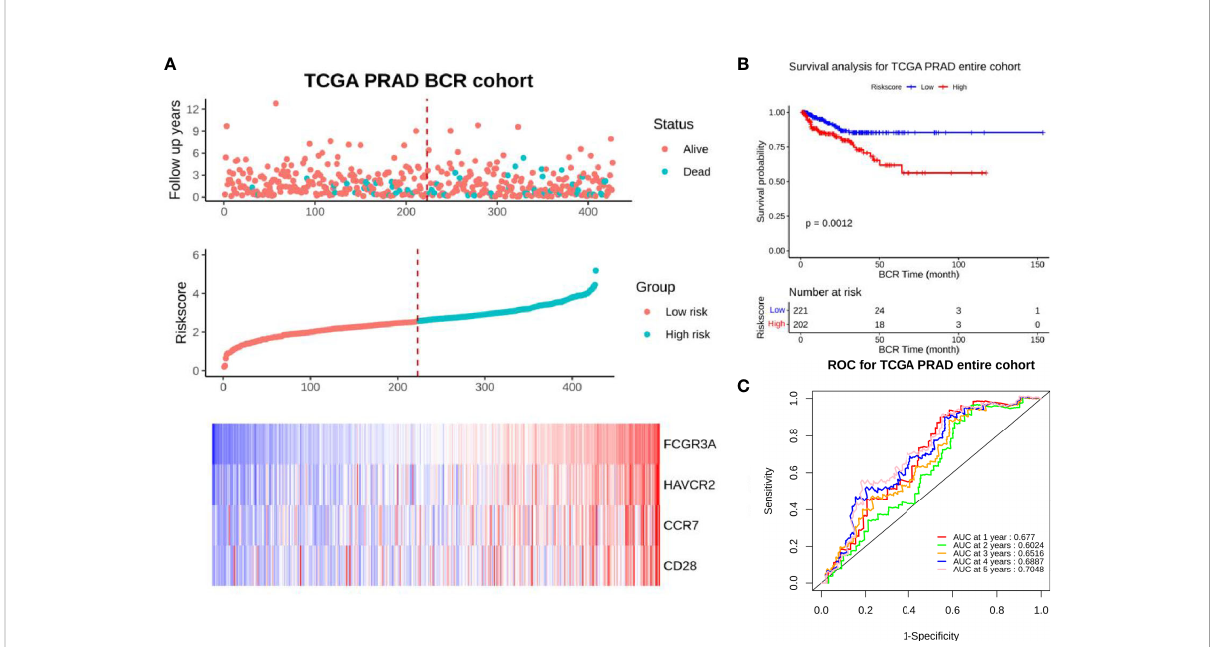
FIGURE 2 Prognostic model analysis of entire set. (A) Distribution of 4 target genes in low-risk and high-risk groups in TCGA-PRAD dataset. (B) BCR free survival curve of 4 target genes in TCGA-PRAD dataset ( P =0.0012). (C) 5-year ROC curve of 4 target genes in TCGA-PRAD dataset (AUC>0.6).